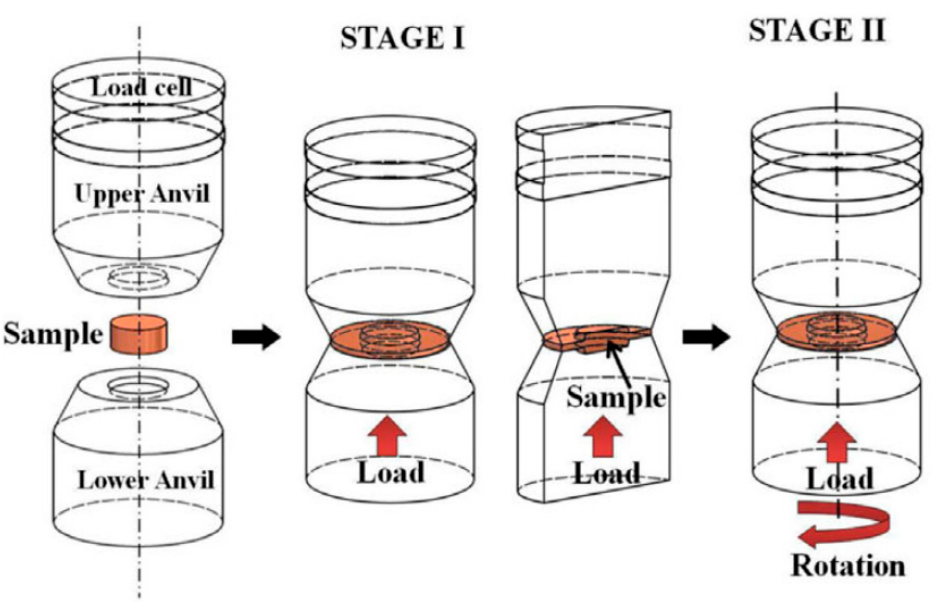
Figure 1. Schematic representation of the HPT apparatus with the uniaxial compression (I) and subsequent simultaneous compression and torsion (II) stages [46].